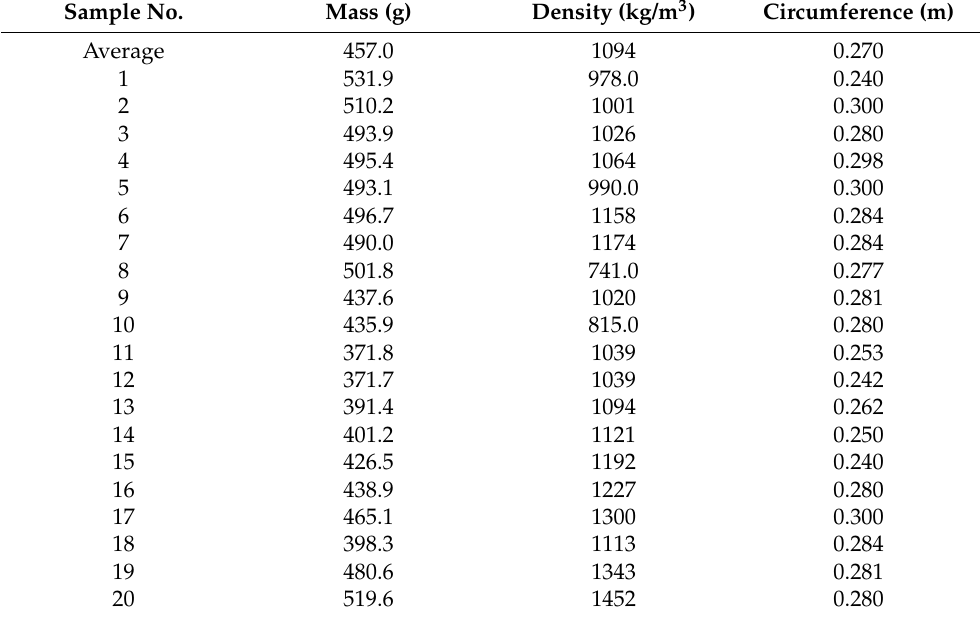
Table 1. Mass, density, and circumference of mangoes.